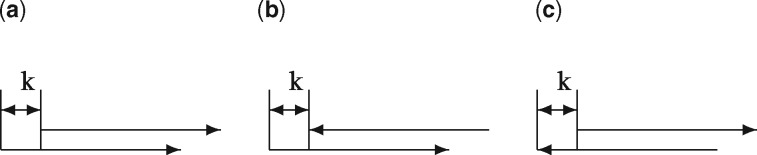
Three types of overlapping hit with a shift of k between the motif starts. The arrows pointing to the right and left represent the (5′ → 3′) and (3′ ← 5′) directions of the DNA, respectively